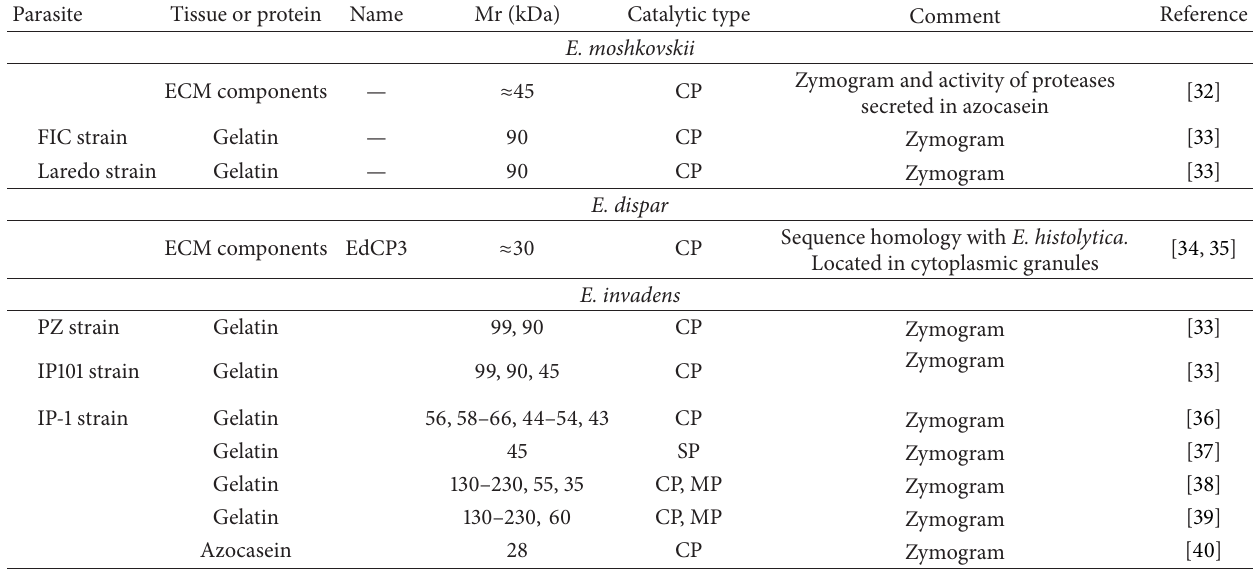
Table 2: Enzymes from E. histolytica related species that degrade host proteins and their implication in virulence.